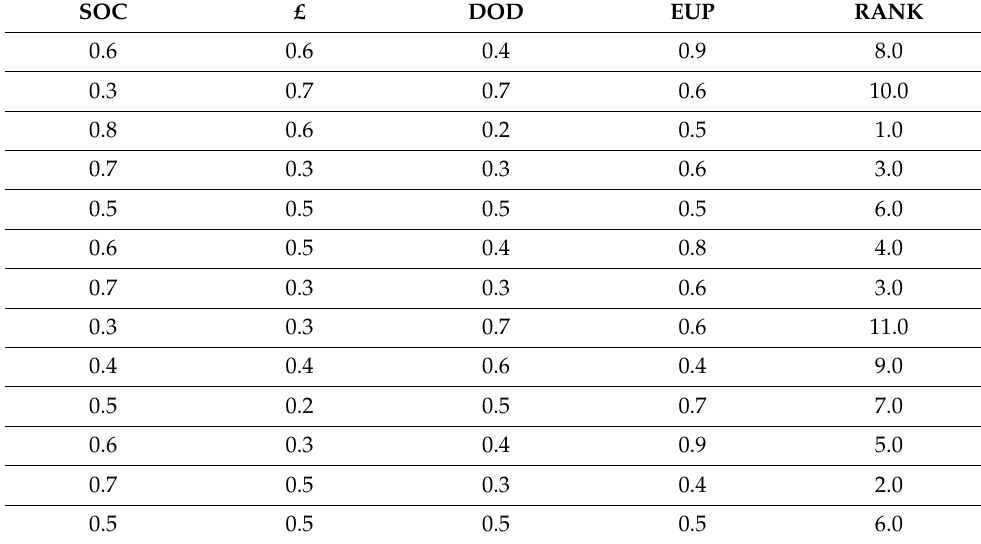
Table 6. Actual ranking of